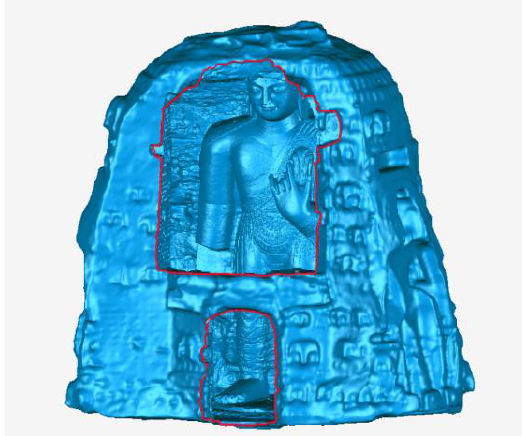
Figure 5. Three-dimensional model of the surface of the 18th Cave of Yungang